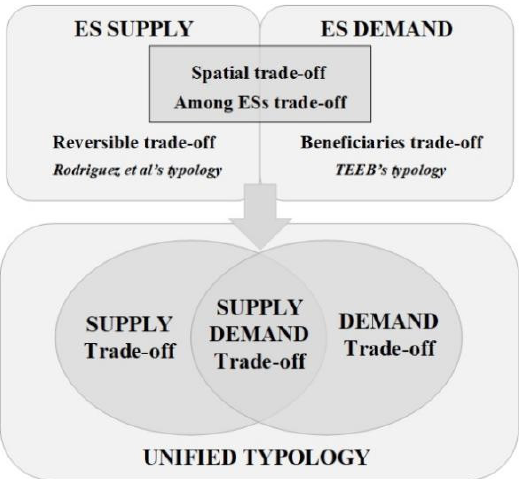
Figure 2. The unified ES tradeoff typology considered both the ES supply and ES demand (Modified from Mouchet, Lamarque, Martín-López, Crouzat, Gos, Byczek and Lavorel [8]).